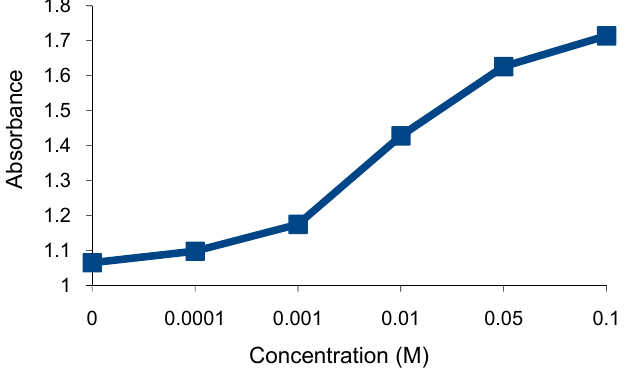
Figure 6. Turbidity absorbance of sensing element vs. concentration of Hg 2+ ions.